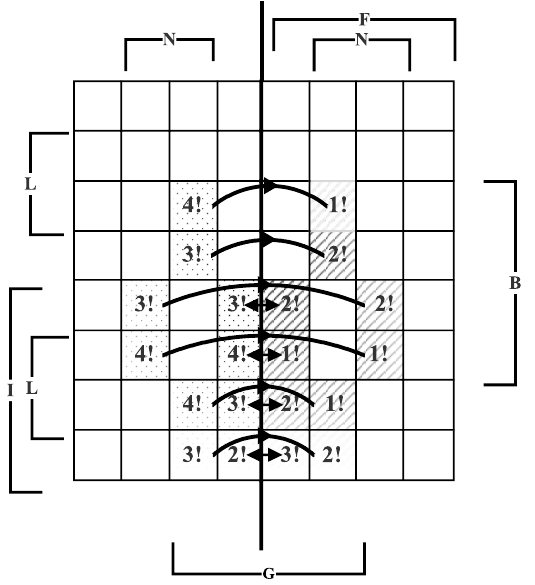
Fig. 8. Transitions from primitive losing coalitions (dotted) to their images across the F-boundary to corresponding primitive winning ones (hatched). These are the transitions in which F is pivotal (critical). Other transitions across the F-boundary are either losing-losing transitions or winning-winning transitions.